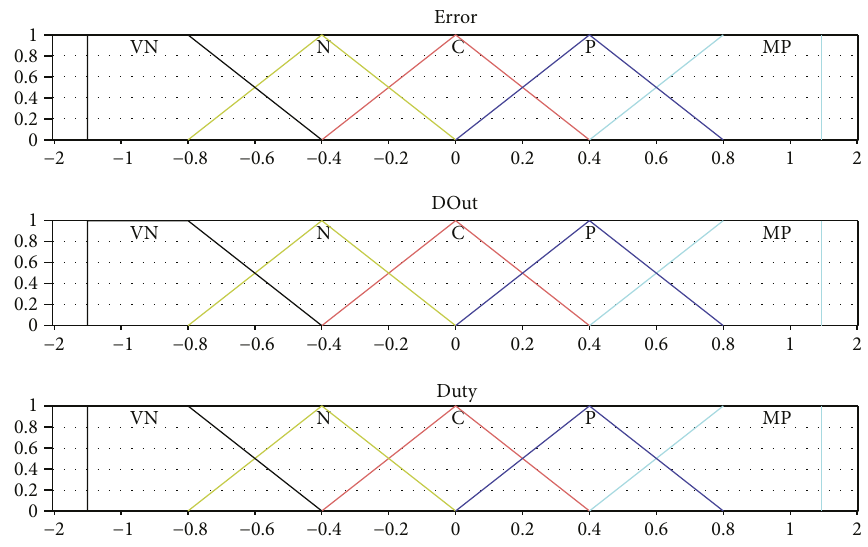
Figure 5: Membership functions for the input and output